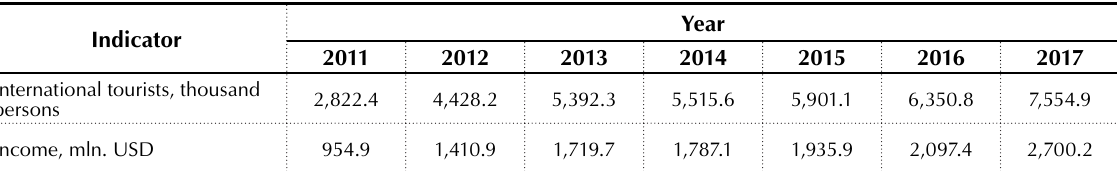
Table 2. Leading countries according to number of international entries to Georgia